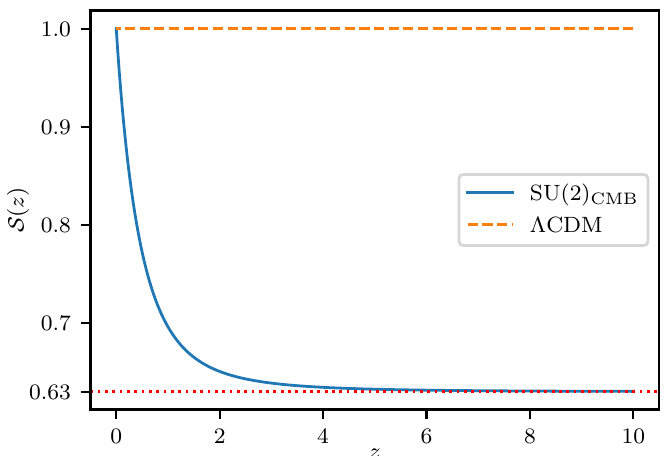
( z ) of Equation(4), indicating the (multiplicative) deviation from the Figure 1. The function S asymptotic T - z relation in Equation(3). Curvature in T 0 = T c . There is a rapid approach towards the asymptotics invariance for T ∼ increasing z . Figure adopted from